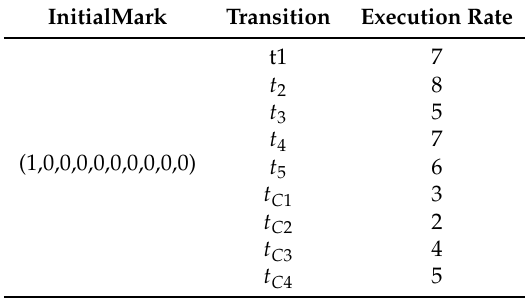
Table 1. Parameter configuration of experiment.